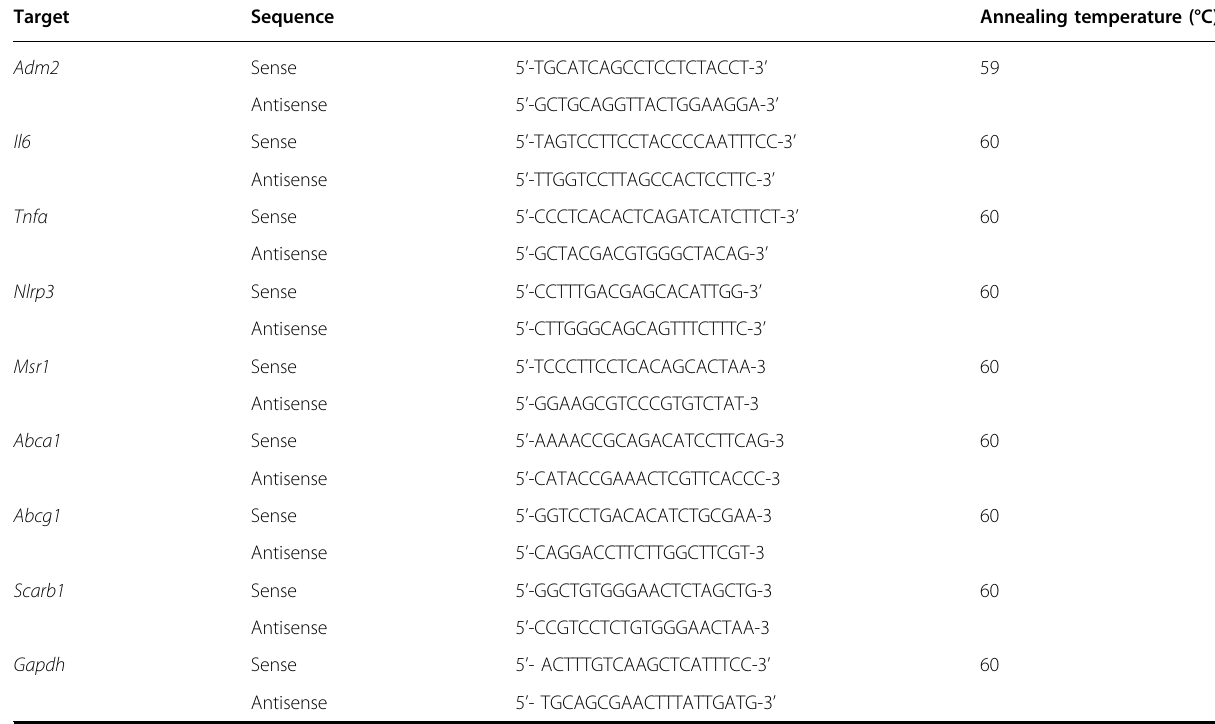
Table 1 Primer sequences for quantitative real-time